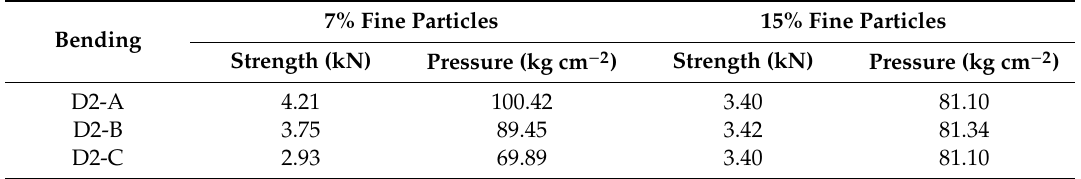
Table 8. Bending assay results for 7% and 15% fine particles.